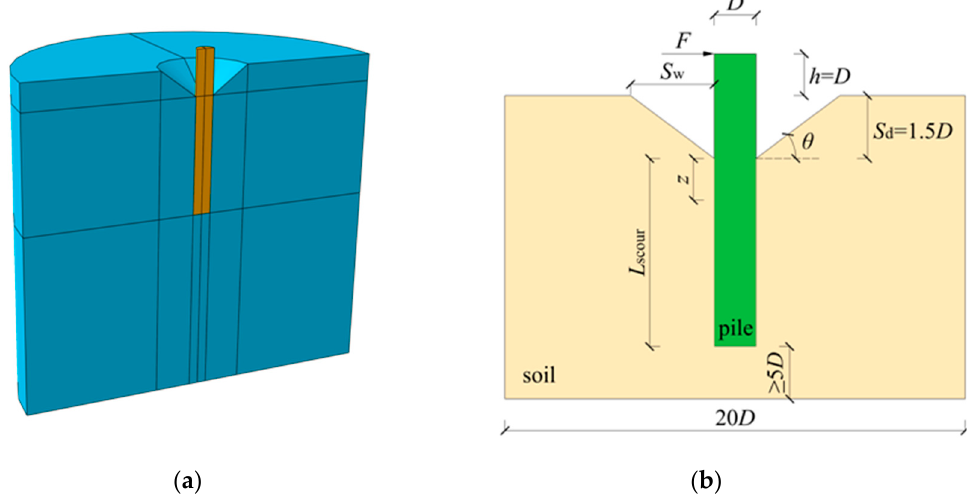
Figure 5. Schematic diagrams of the pile ‒ soil scour model: ( a ) Three-dimensional model in ABAQUS and ( b ) Illustration of parameters of the model. Table 3. Parameters of piles used in numerical model with scour.